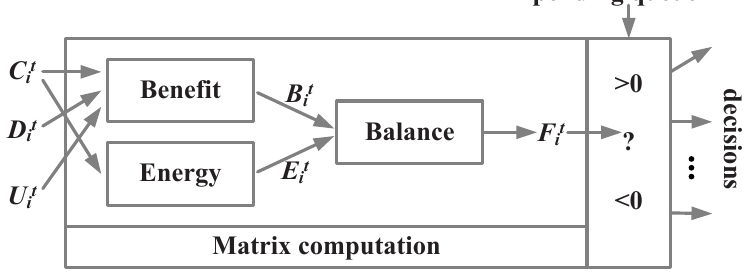
Figure 2. The frame of matrix-based Data Relay